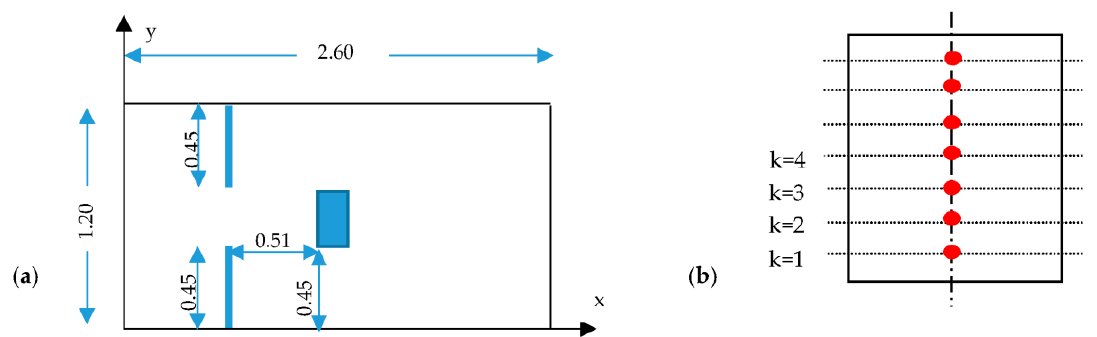
Figure 1. ( a ) Configuration of experiment test (dimension in meters); ( b ) Gauges on the vertical front face of building. In 2D numerical solutions, with the hypothesis that the pressure was hydrostatic, the net force perpendicular to the vertical wall at each time step was estimated by applying a momentum equation to the control volume taken around the obstacle. The force per unit width (including the hydrostatic load and momentum flux term) calculated for each